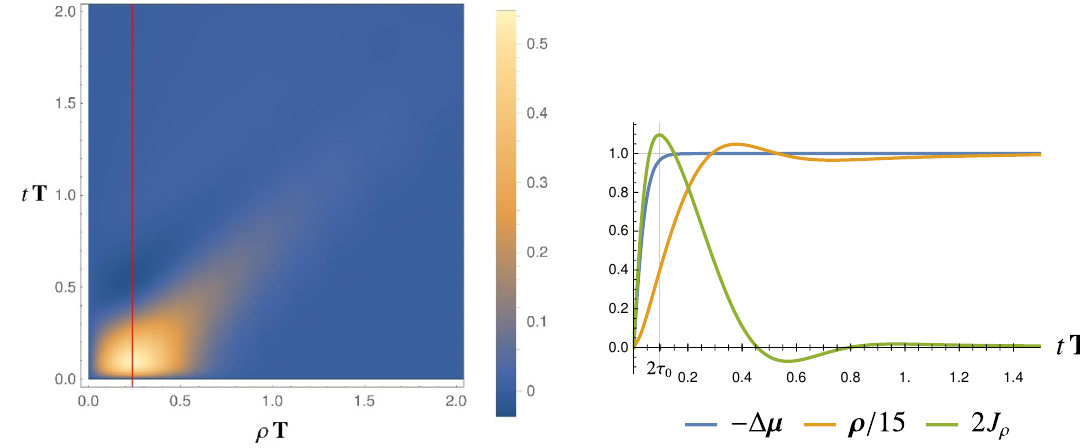
Figure 3 . Fast quench (cid:28) = 0 : 5 z h = 0 : 12 T (cid:0) 1 . Left: the pro(cid:12)le of the radial current depending on time t . The expanding wave of the current at t (cid:28) (cid:28) is visible. Right: the time-dependence of the local chemical potential and charge density at (cid:26) = 0 and the current density at (cid:26) (cid:25) 0 : 25 T (cid:0) 1 (shown by red gridline on the